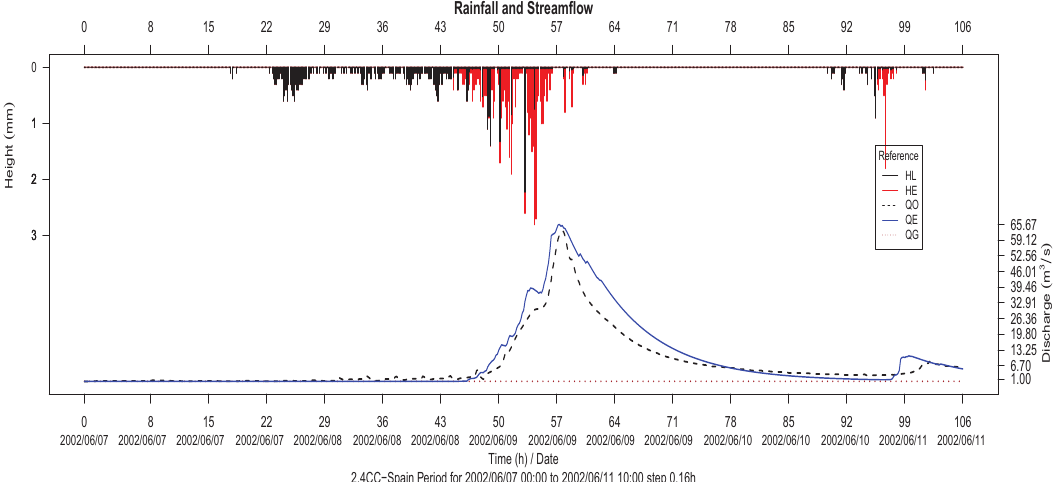
Figure 10. Hyetograph and Hydrograph from calibration data series 2.4CC of Artibai barin, Bizkaia, Spain.